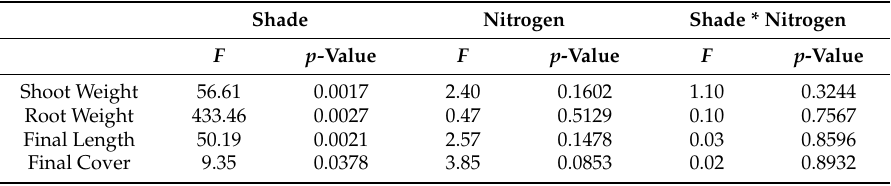
Table 1. F statistics and p- values from Type III tests of the fixed effects of shade, nitrogen, and shade and nitrogen interaction from mixed effects models with response variables of Idaho fescue shoot and root weight, final shoot length, and final plant cover.